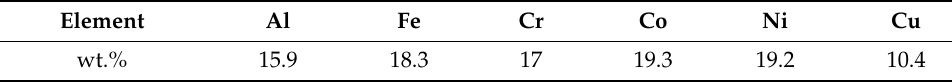
Table 1. Nominal composition of the alloy FeCrCoNiAl 1.8 Cu 0.5 . Element Al Fe Cr Co Ni Cu